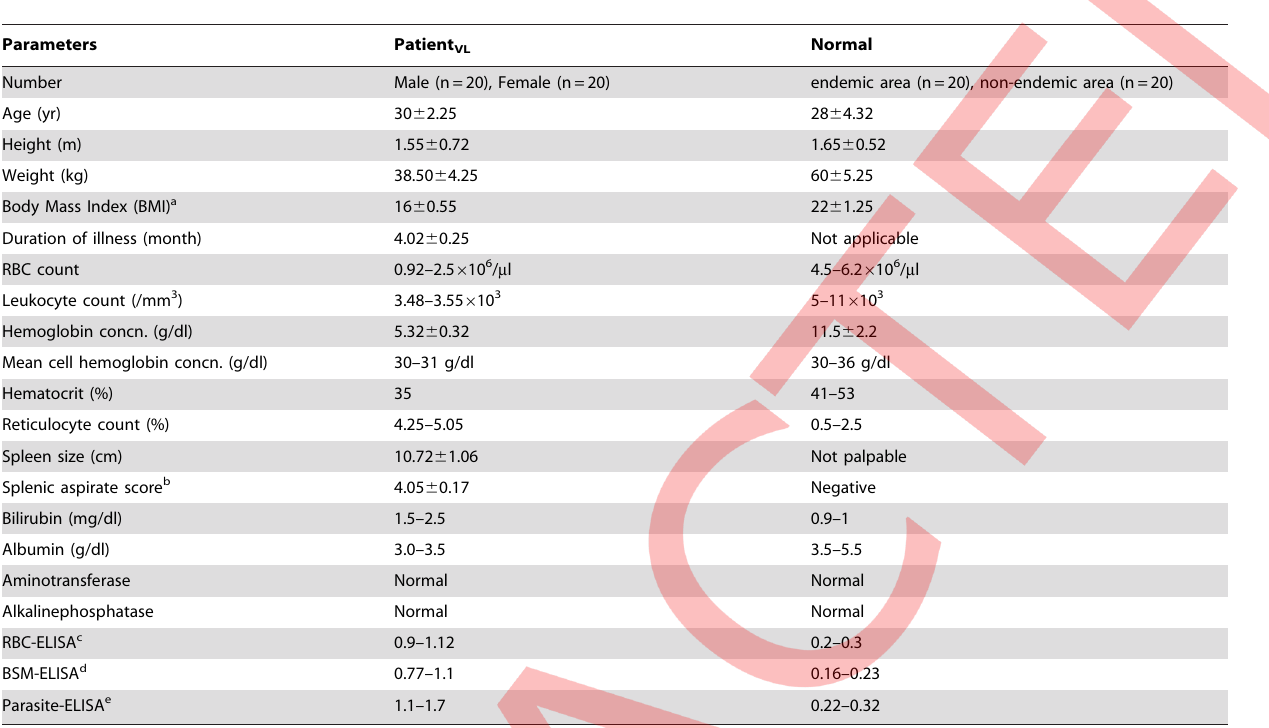
Table 1. Clinical and laboratory features of patients with visceral leishmaniasis (VL).